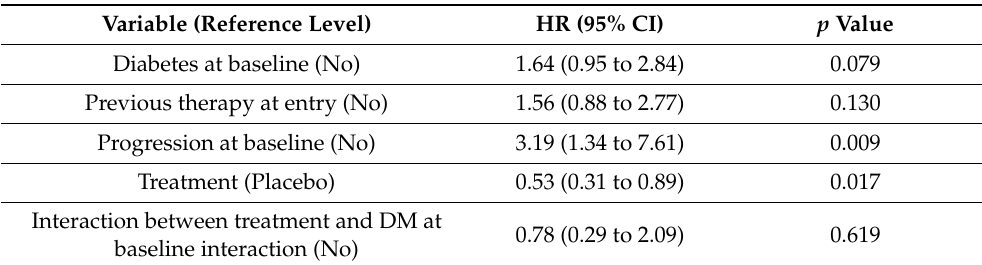
Table 2. Exploratory analysis to investigate the influence of DM status at baseline covariate on PFS (intention-to-treat